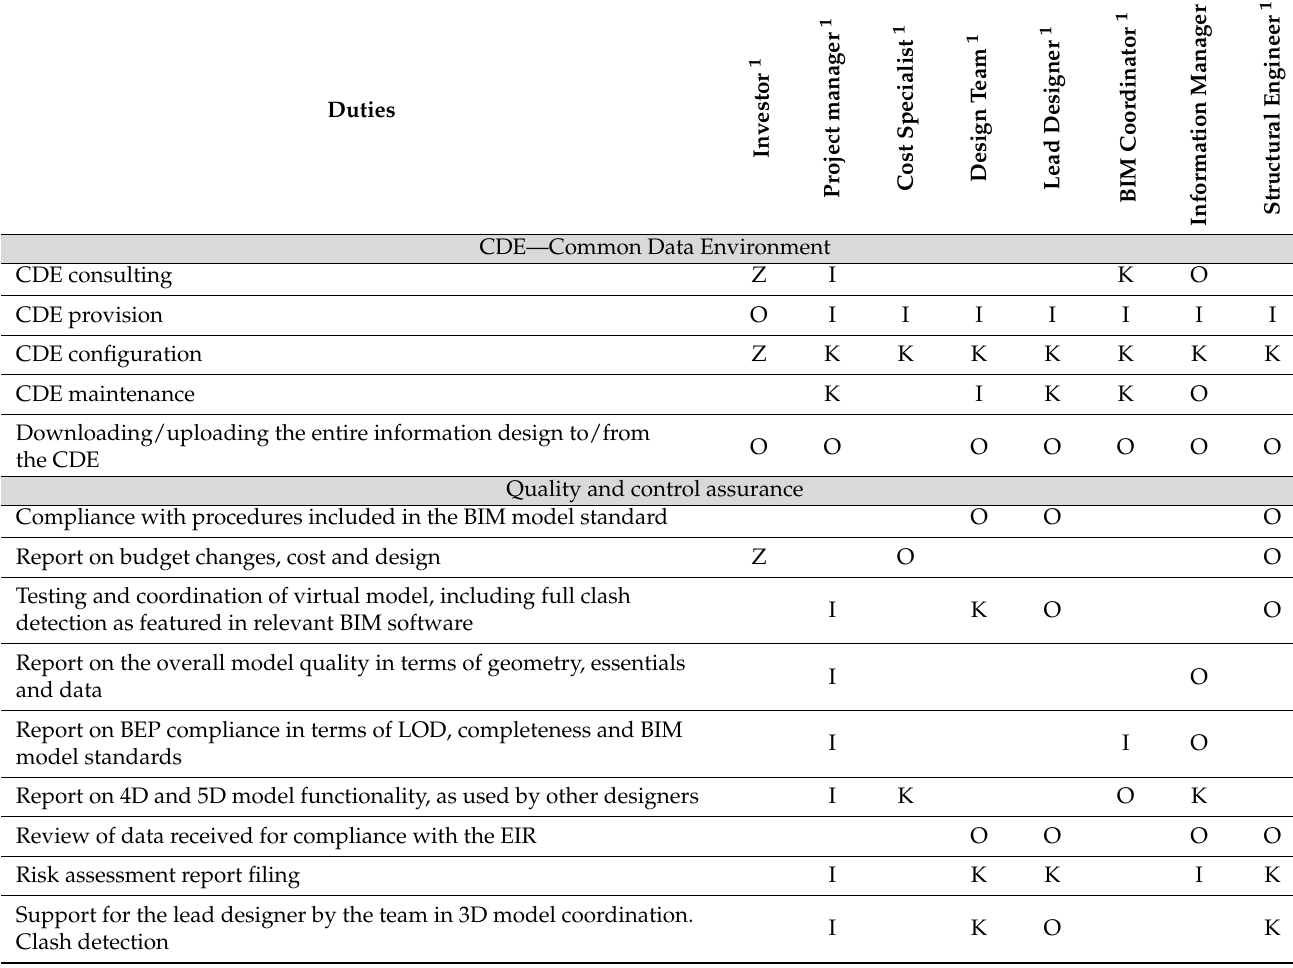
Table 4. Fragment of an appendix to the EIR of the Copernican Revolution Studio on scopes of responsibility.